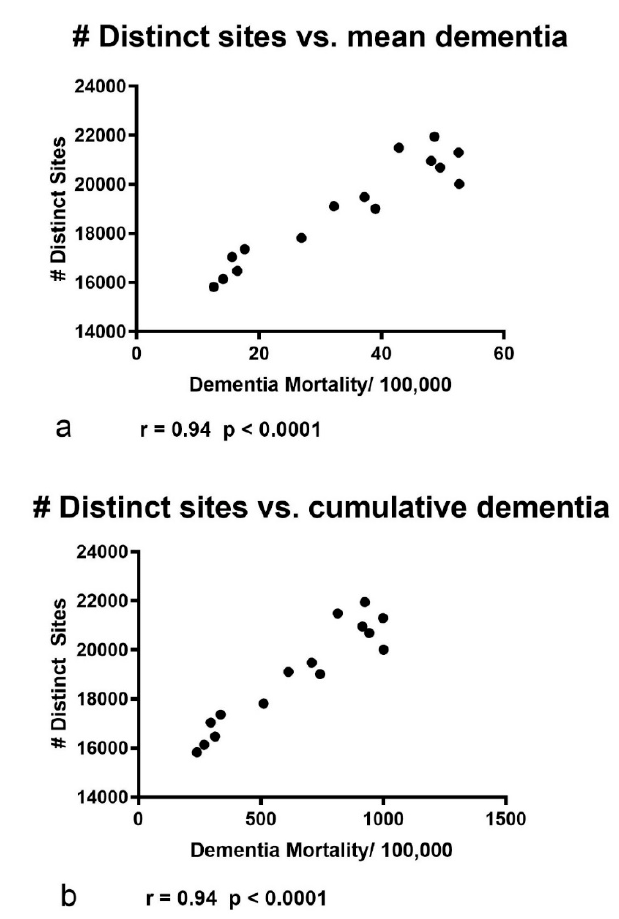
Figure 7. Pearson’s r correlation analyses of mean and cumulative vascular and unspecified dementia mortality versus the number of distinct mining sites. ( a ) A significant correlation was found between the number of distinct sites per year vs. the mean age-adjusted vascular and unspecified dementia mortality / 100,000 population per year (r = 0.94; p < 0.0001; xy pairs = 15; data depicted in Figure 6). ( b ) A similar analysis comparing the total number of distinct sites to the cumulative age-adjusted dementiamortality / 100,000populationperyearyieldedidenticalresults(r = 0.94; p < 0.001; xypairs =